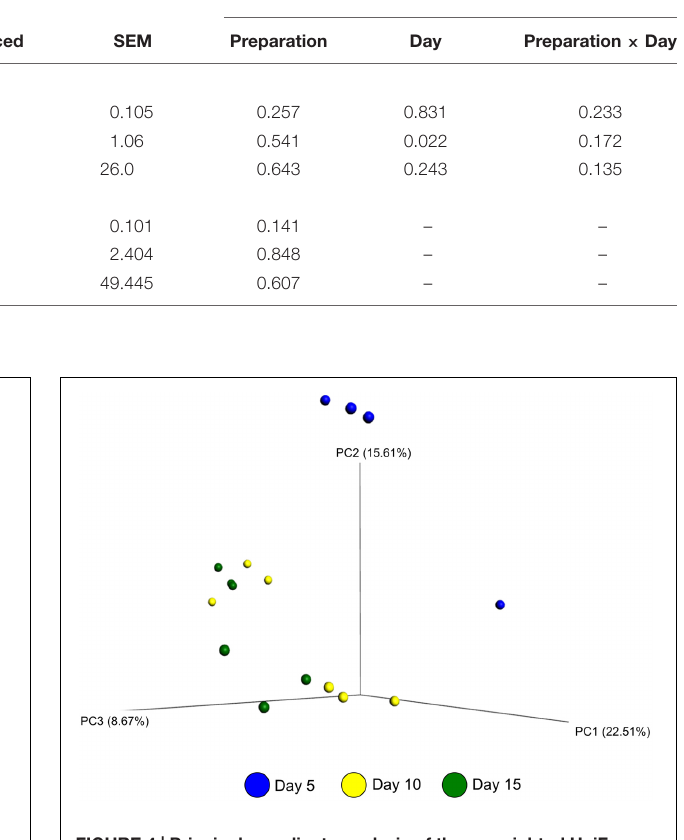
FIGURE 4 | Principal coordinate analysis of the unweighted UniFrac distances for LAM samples at different sampling days. The percent variation explained by each principal coordinate is indicated on the axes. Original rumen samples are excluded. LAM, liquid-associated